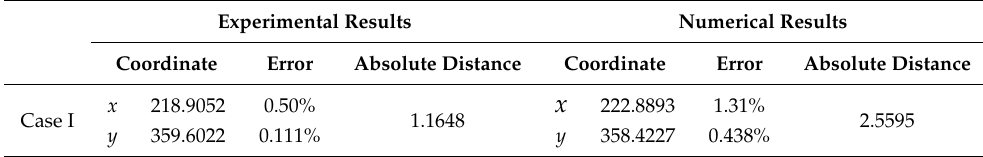
Table 11. Experimental and simulation results of 8 sensors under Case